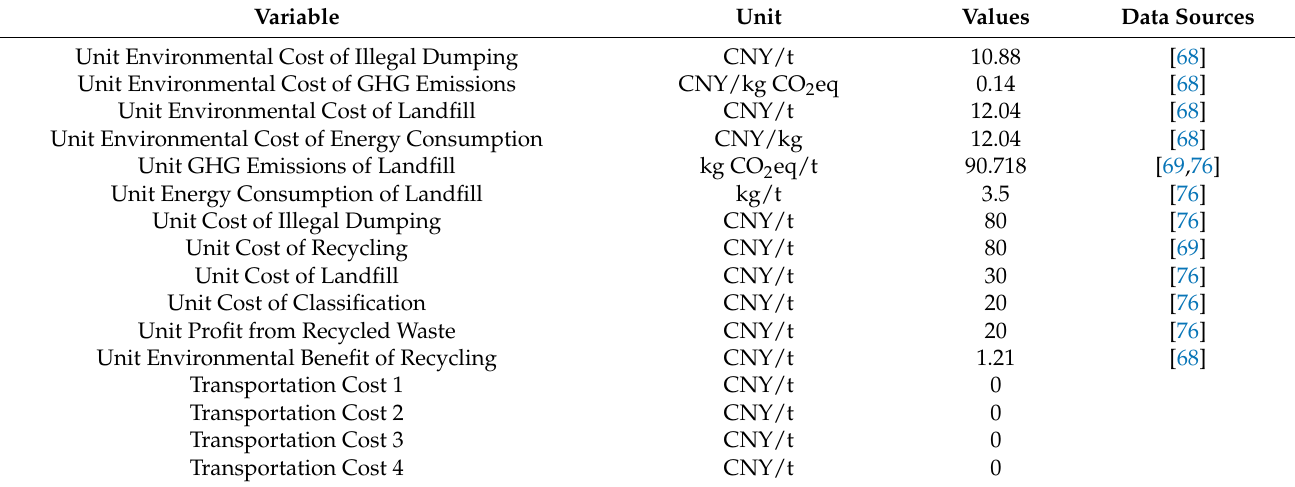
Table A5. Constant values.